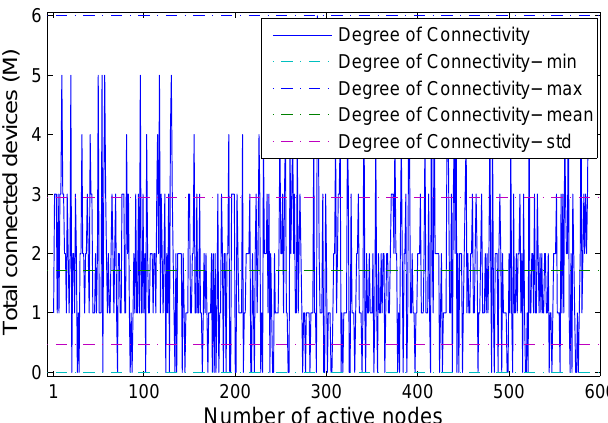
Figure 4. Average degree of each device vs. total number of transmitting devices.